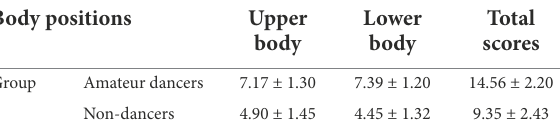
TABLE 3 Mean motor imagery scores for upper and lower body movements (M ±